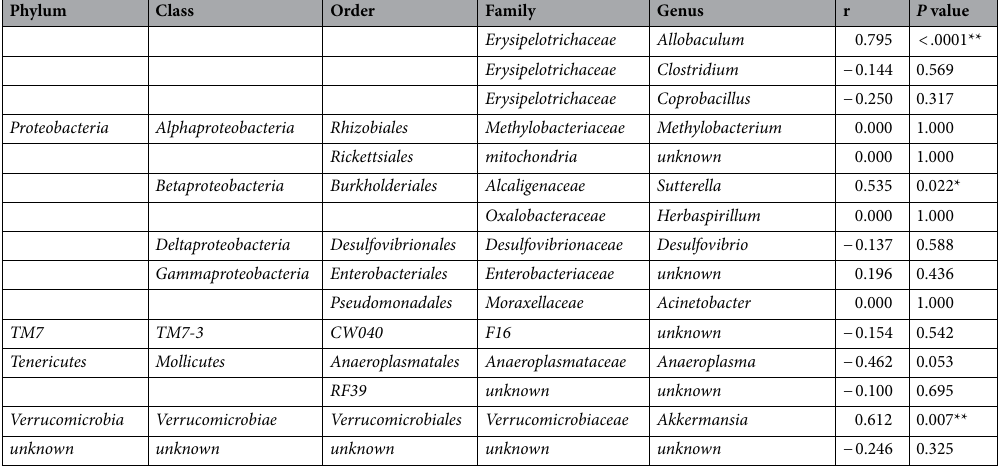
Table 1. Correlation between fecal Crps and microbiota at genus level. Red; * P < 0.05, ** P < 0.01.